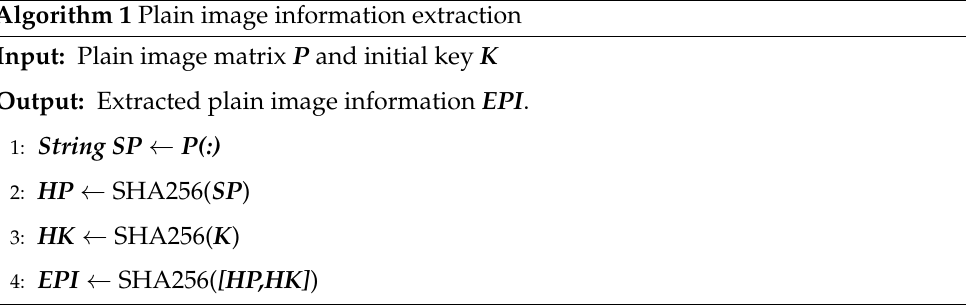
Algorithm 1 Plain image information extraction